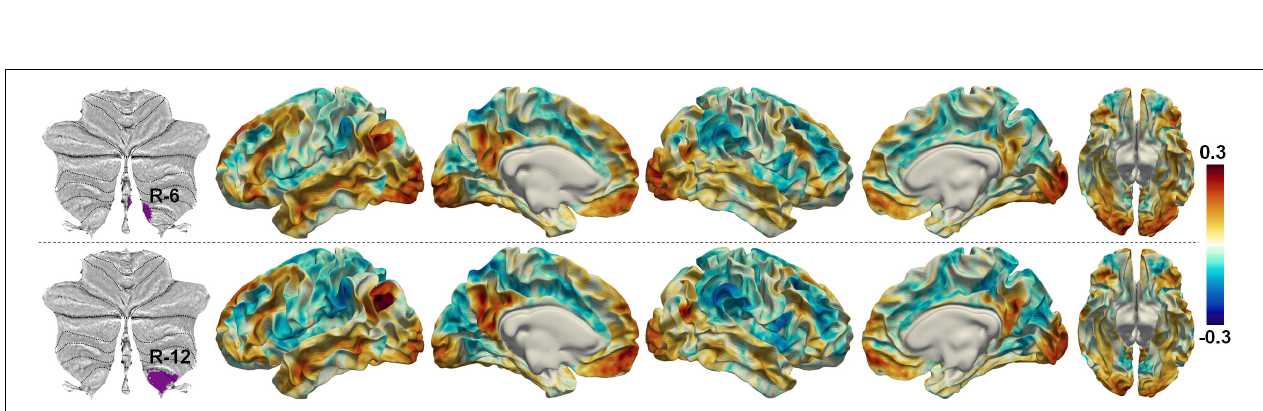
Frontiers in Neuroscience |